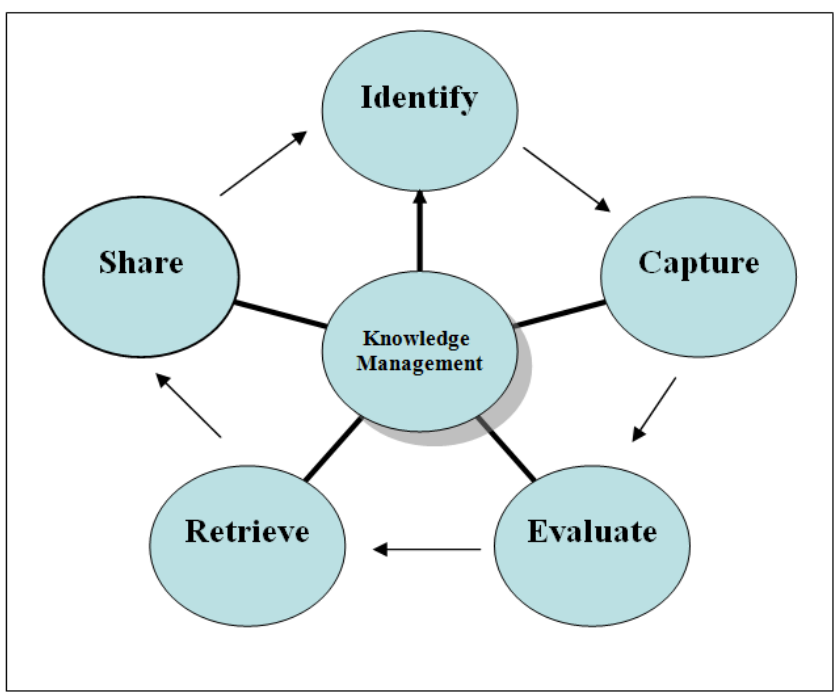
Fig. 1. Knowledge management process (Oliver & Kandadi,